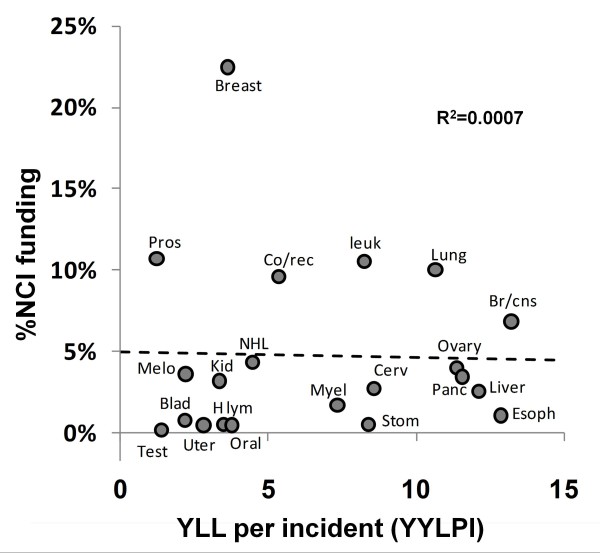
NCI research funding relative to YLLPI. Dashed line indicates linear regression and the R2 of 0.0007 indicates that NCI research funding is not associated with YYLPI. Removal of the extreme value for breast cancer from this plot does result in a slight non-significant positive relationship (R2 = 0.0223).